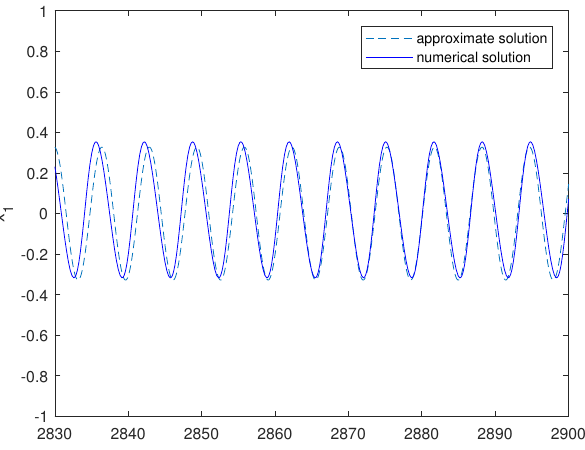
Figure 8. Comparison of the approximate analytical solution and numerical solution. The dotted line represents the approximate analytical solution, and the solid line represents the numerical